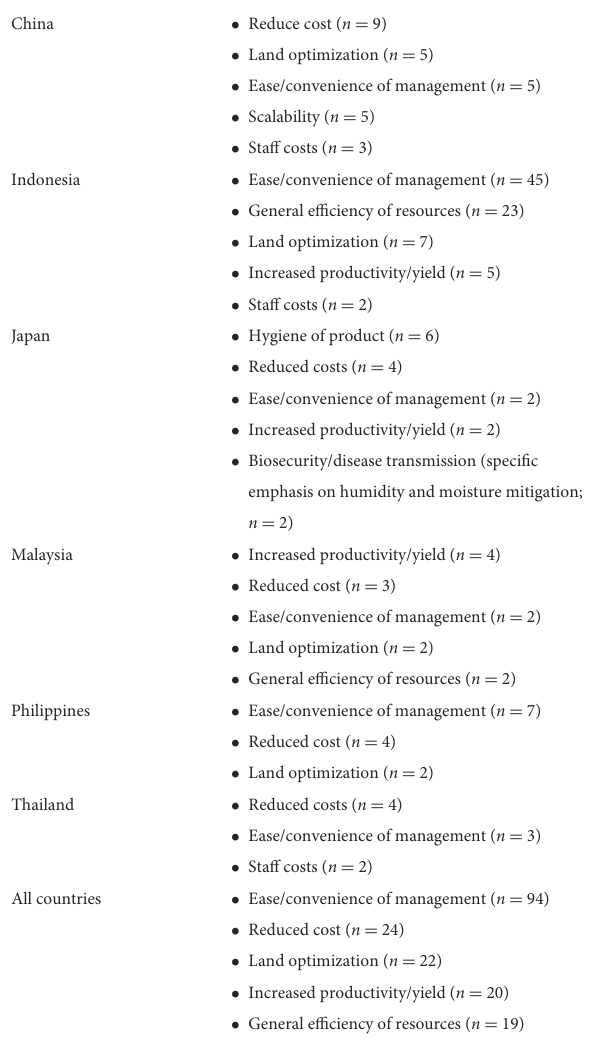
Themes—number of